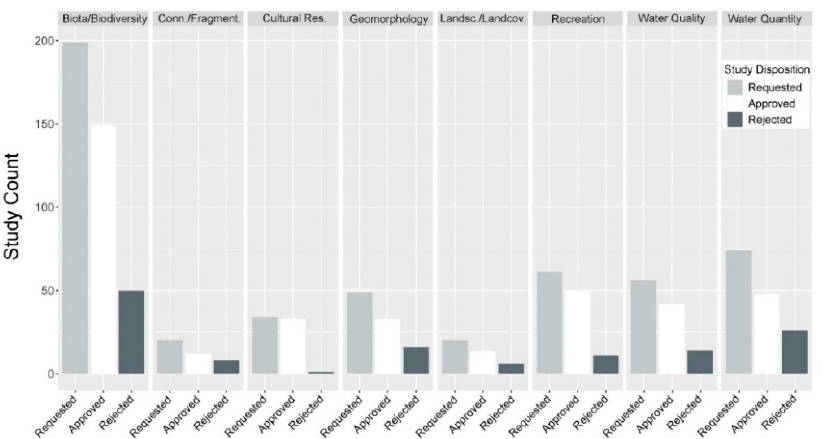
Figure 3. Total number of studies that were approved, rejected, or requested in each category for the 23 projects in dataset 1, analyzed using study determination letters.